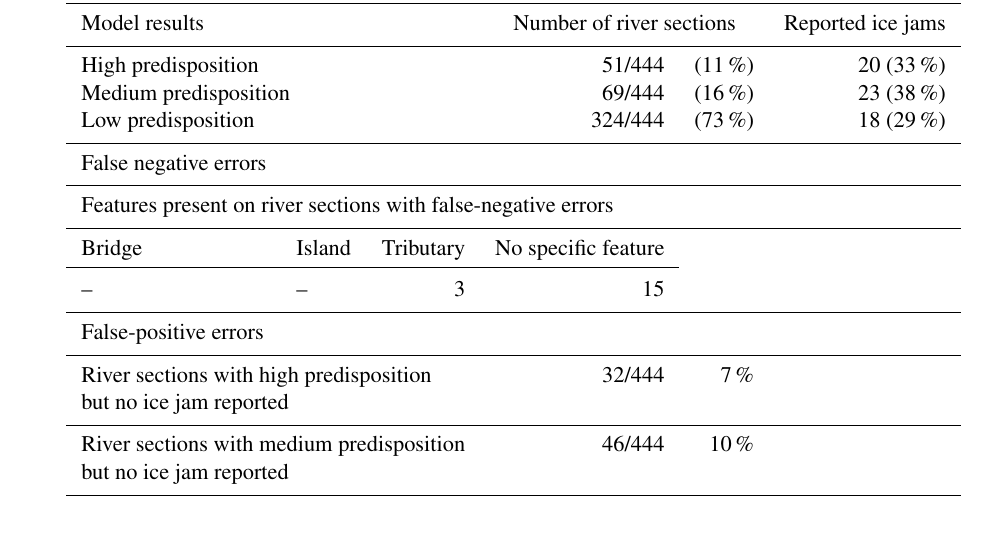
Figure 6. Map of the model results on the Chaudière River, over 250m sections. Thumbnails are the locations of reported ice jams. Blue is used when the ice jam falls on a section with a moderate to high predisposition (correct assessment). Magenta is used when the ice jam falls on a section with a low predisposition (false-negative error). Table 4. Results and accuracy of the IJPI on the Chaudière